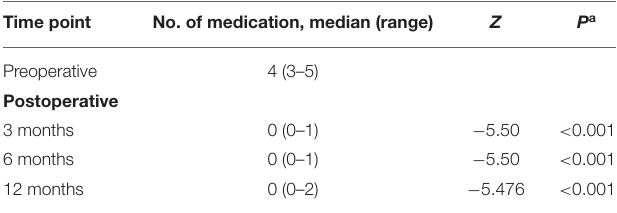
TABLE 4 | Number of medications before surgery and at 3, 6, and 12 months after surgery.